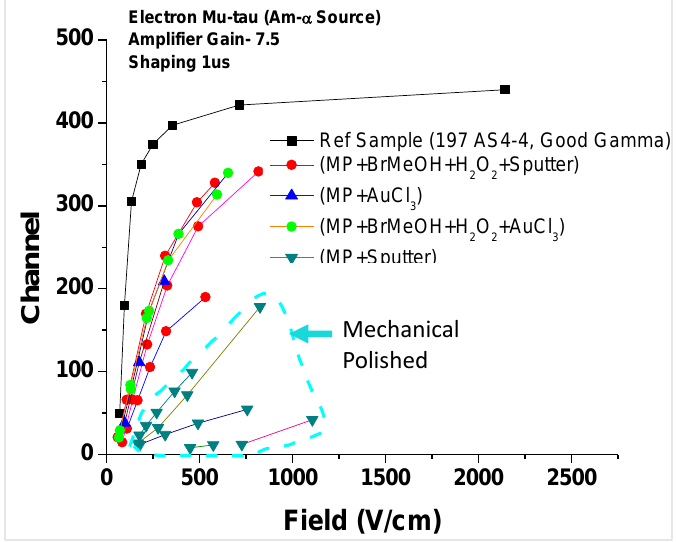
Figure 17. µτ e products determined by using 241 Am- source for different treated surfaces in CRY-3 detectors.